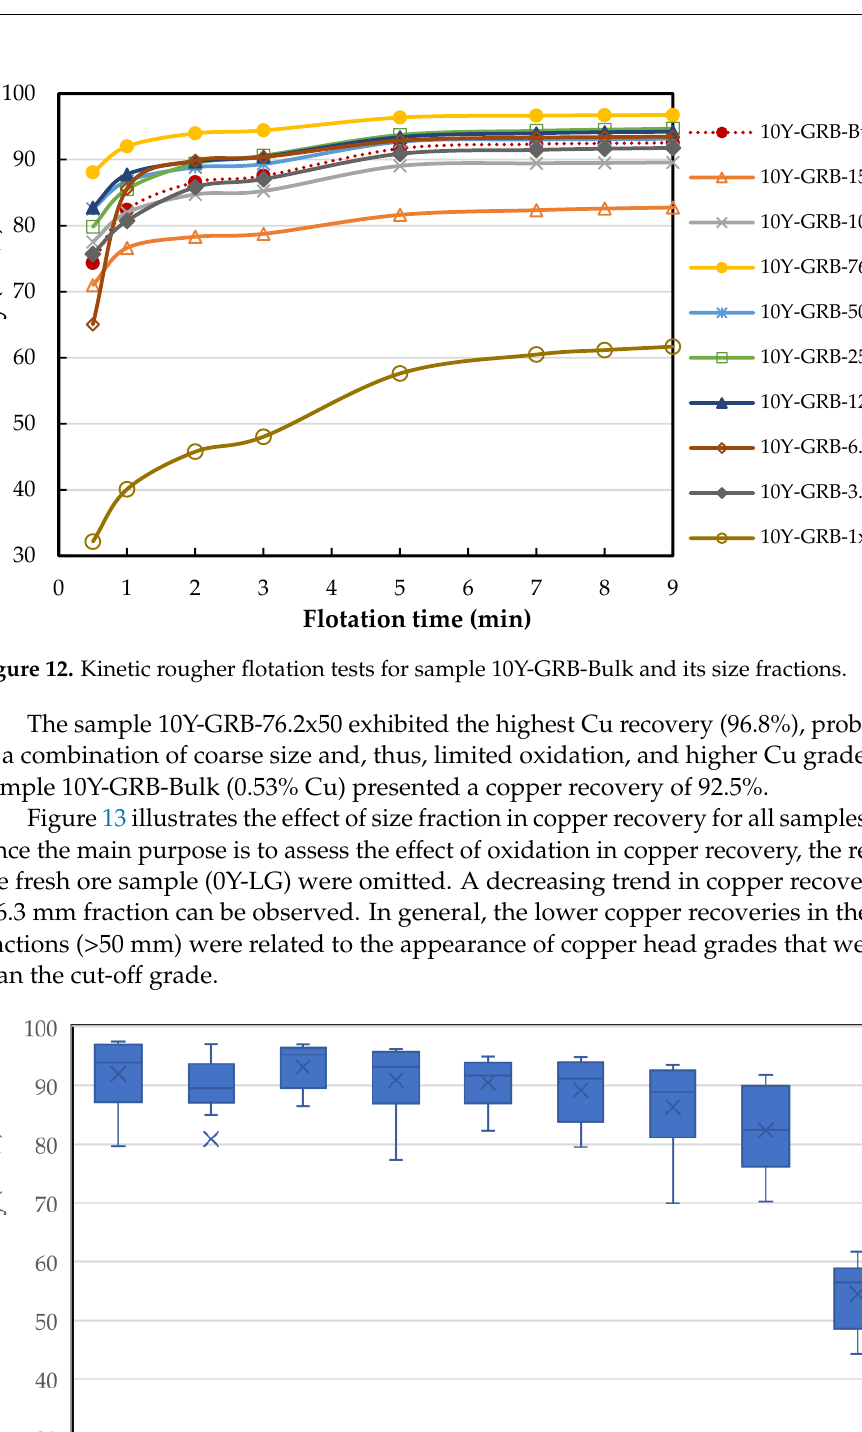
Figure 13. Box plot of copper recovery in rougher flotation for the different size fractions for all stockpiled samples.